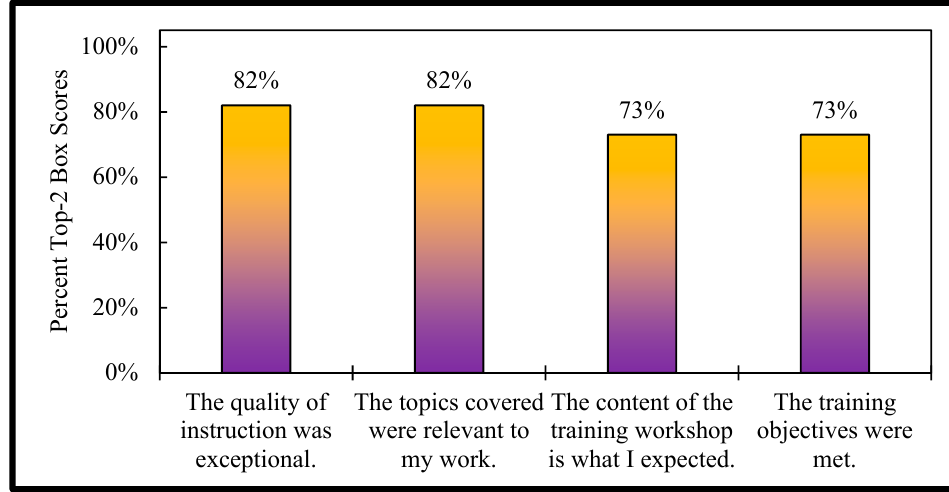
Figure 16. Percent of positive responses on workshop content.